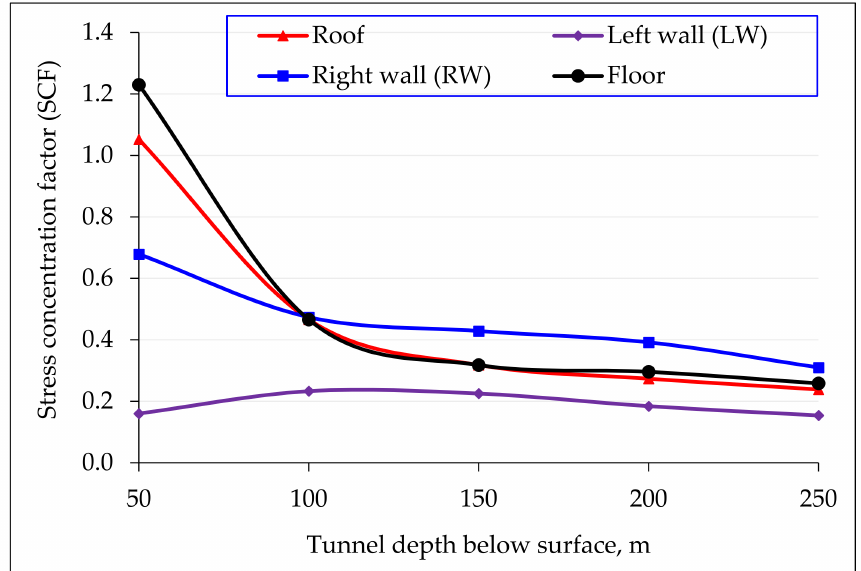
Figure 20. Stress concentration around tunnel opening at various depths below surface.